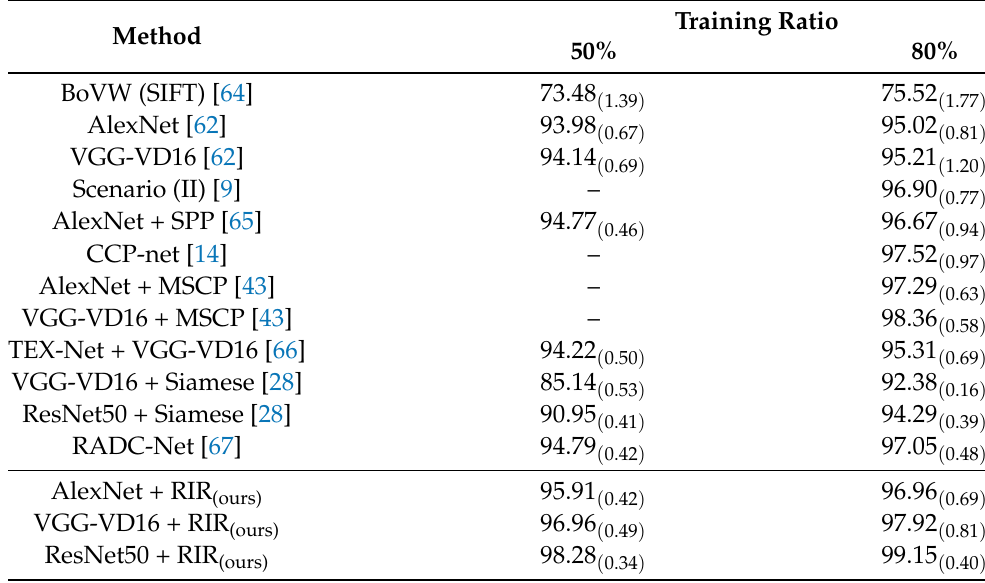
Figure 8. Confusion matrices of the VGG-VD16-based baseline DCNN and RIR-net for the UCM dataset (training ratio = 80%). ( a ) VGG-VD16-based baseline DCNN; ( b ) VGG-VD16-based RIR-net. Table 3. Comparison of overall accuracies (OA) (%) on the UC dataset (training ratio =